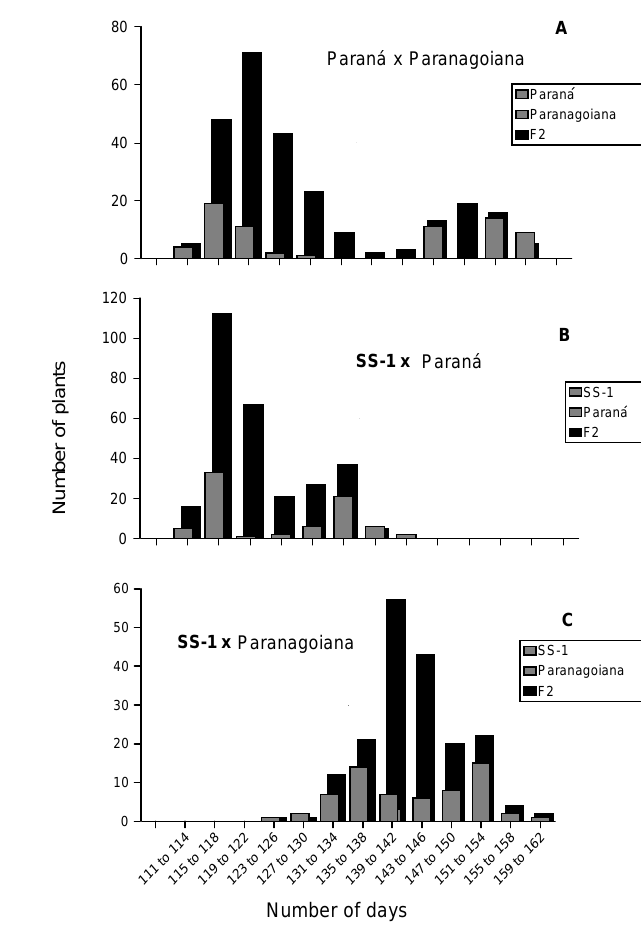
Figure 1 - Frequency of plants of parents and of F ber of days to flowering in three soybean crosses.